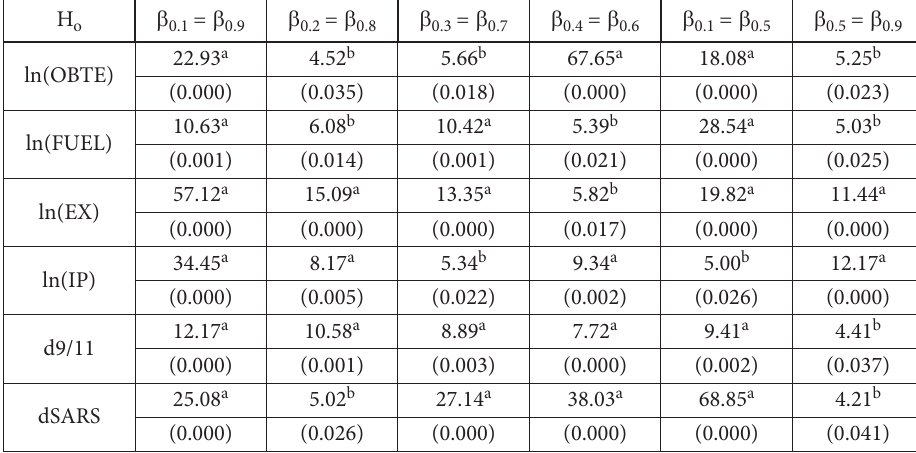
Table 4. Model 2: Results of the symmetric quantile test H o